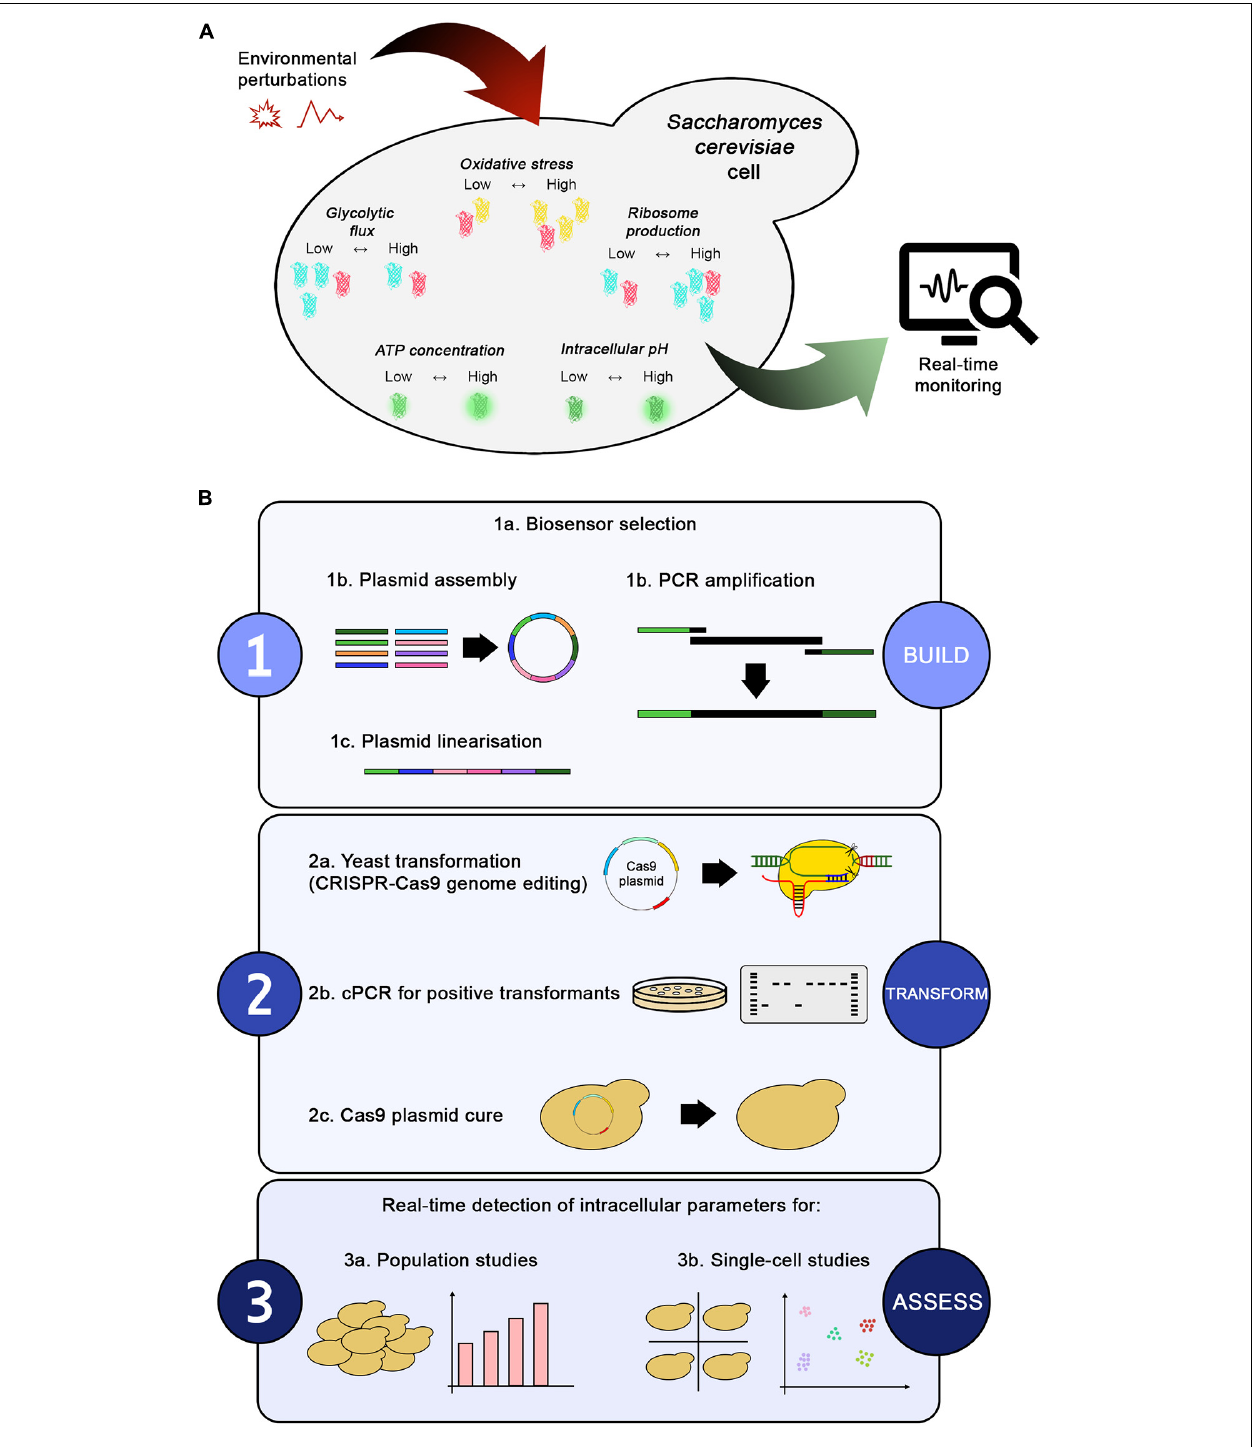
FIGURE 1 | Toolbox overview and workflow. (A) Environmental perturbations in a bioprocess directly affect the intracellular environment of a yeast cell. The biosensors present in the toolbox enable real-time monitoring of changes in intracellular parameters, such as glycolytic flux (with GlyRNA), oxidative stress (with OxPro), ribosome production (with RibPro), intracellular pH (with sfpHluorin), and ATP concentration (with QUEEN-2m). (B) The workflow for generating the toolbox can be summarized in three steps: (1) building the desired biosensor, (2) transforming yeast, and (3) assessing the biosensors’ output under different conditions. Once selected, the biosensors can be assembled into plasmids or amplified by PCR to obtain marker-free constructs used for genome integration via CRISPR-Cas9 editing technology. Positive transformants are confirmed by colony PCR, followed by curing of the Cas9 plasmid to remove the selection markers. Finally, the new strains can be used for population or single-cell studies. Alternative plasmid assembly or genome integration methods can be easily fitted in the workflow.